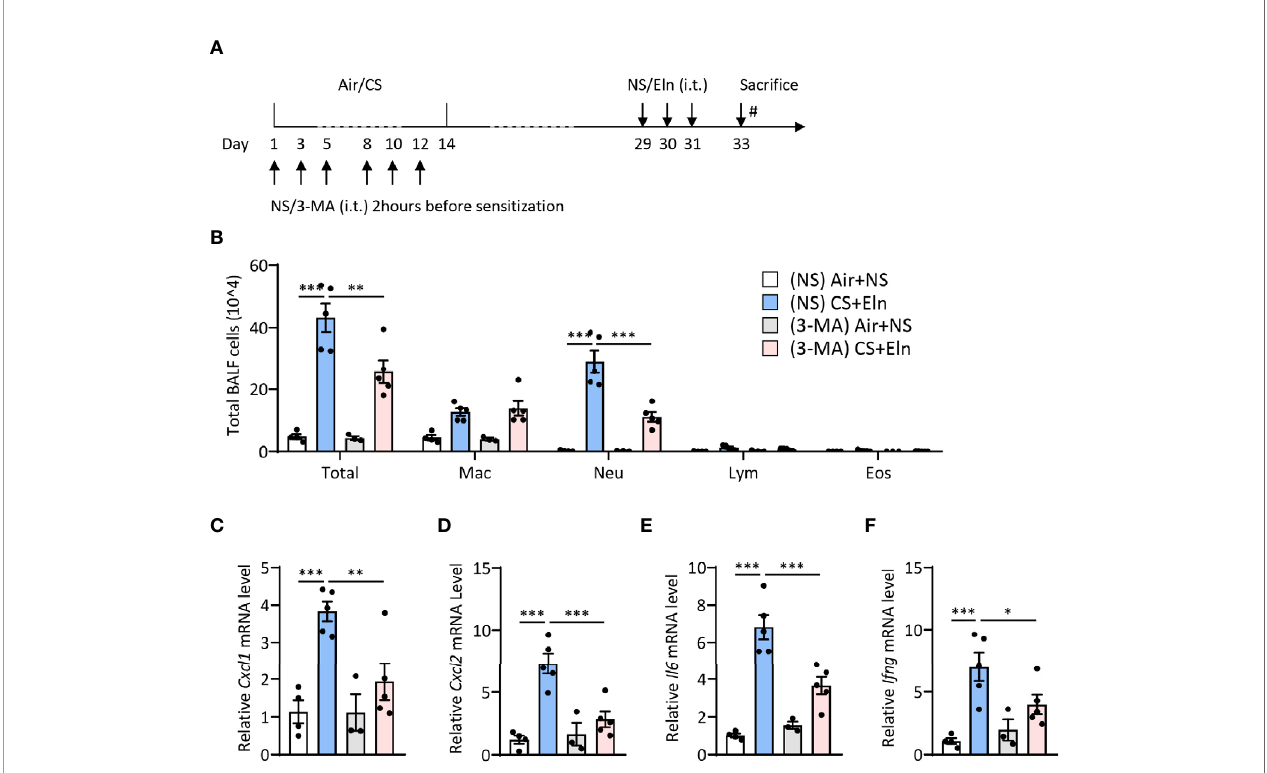
FIGURE 4 | Inhibition of autophagy during CS sensitization alleviates the neutrophilic airway in fl ammation in vivo. (A) experimental outline and protocol for 3-MA treatment, 3-MA (4 mg/ml, 50 m l) was administrated intratracheally 2 hrs before each indicated CS exposure day. (B) In fl ammatory cell counts in the BALF. (C – F) The Cxcl1 , Cxcl2 , Il6 and Ifng mRNA transcripts in lungs. Labeling for all the columns throughout Figure 4 was shown in (B) . Mac, macrophages; Neu, neutrophils; Lym, lymphocytes; Eos, eosinophils. Throughout, data are representative of 3-5 mice and were replicated in at least 3 independent experiments. Data are presented as mean ± s.e.m. * p < 0.05, ** p < 0.01, *** p < 0.001 by one-way